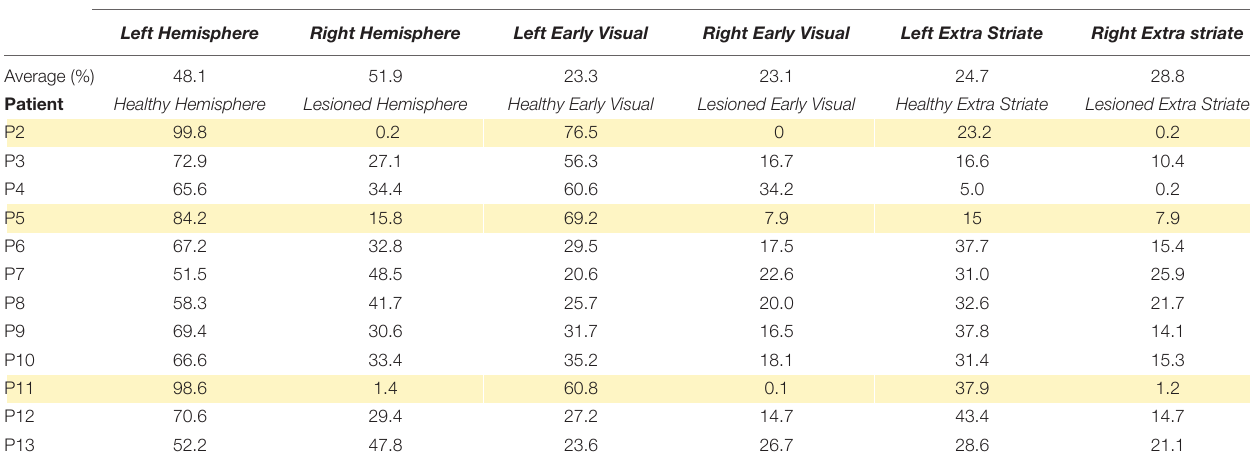
TABLE 3 | Location of voxels contributing to Coverage Maps based on MP. Healthy Amount of voxels (in%) that have contributed to the MP Coverage Map Left Hemisphere Right Hemisphere Left Early Visual Right Early Visual Left Extra Striate Right Extra